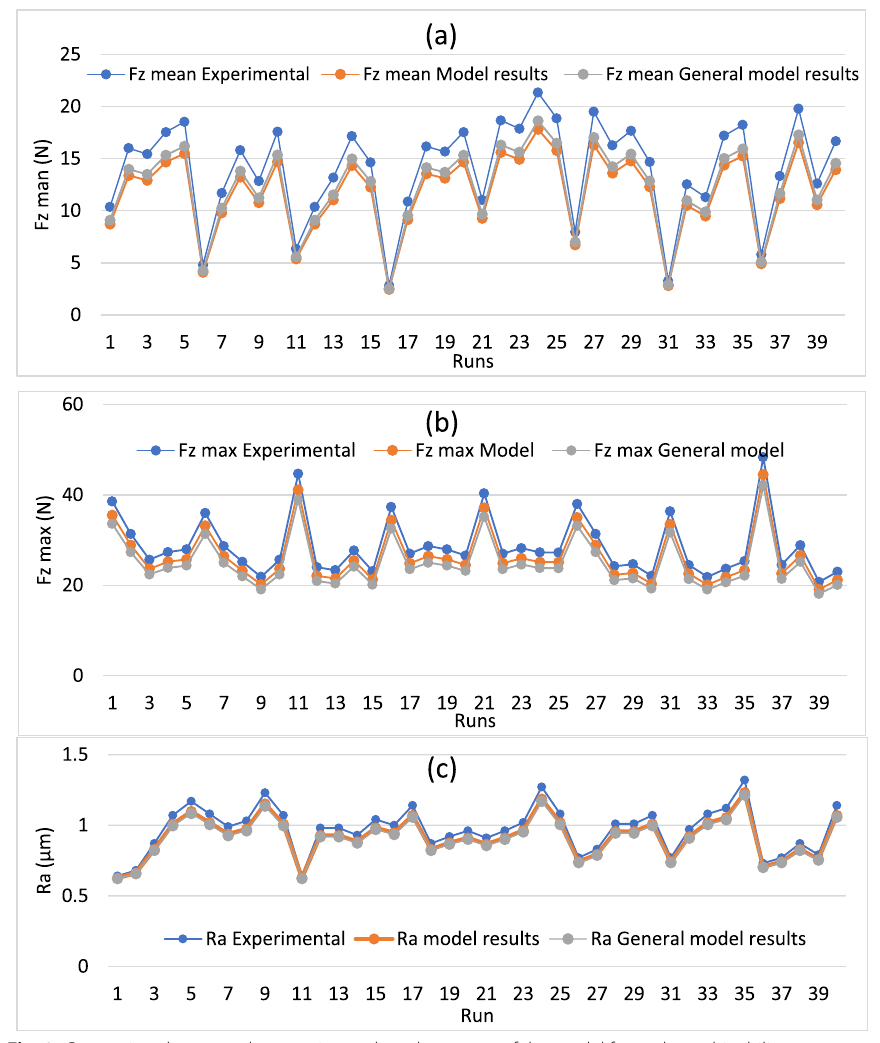
Fig. 8 Comparison between the experimental results, output of the model for each machinability measurement, and the output of the general model from the three measurements. a Mean thrust force (Fz mean), b maximum thrust force (Fz max), and surface roughness